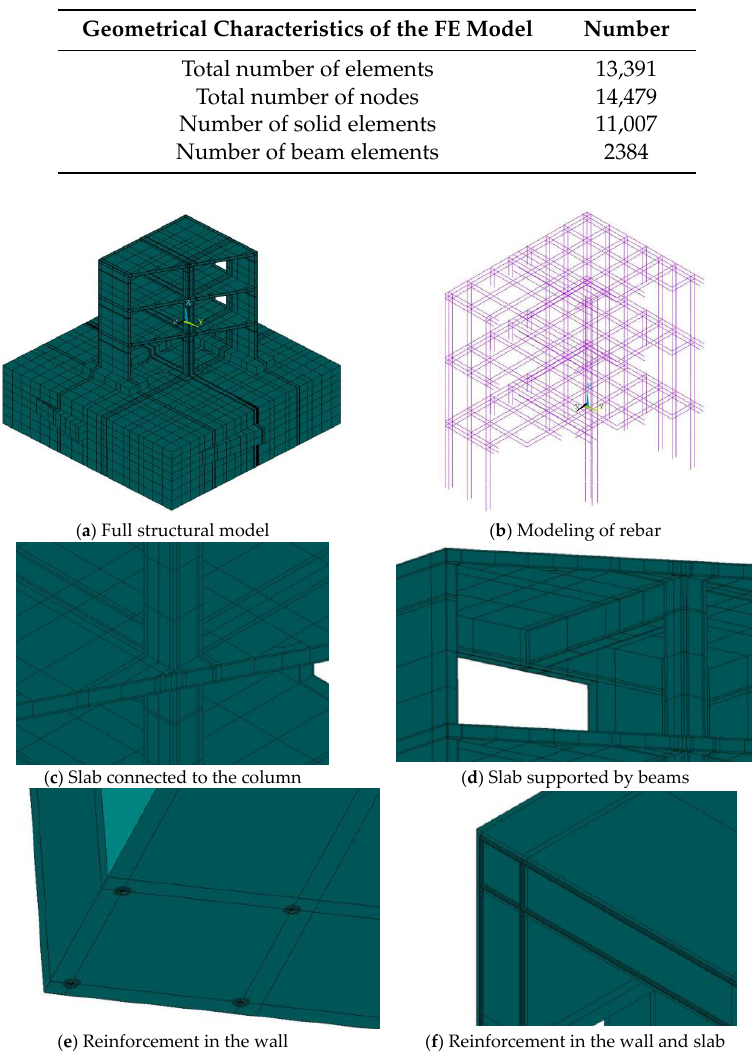
Figure 14. Finite element modeling of the SMART 2013 RC structure.